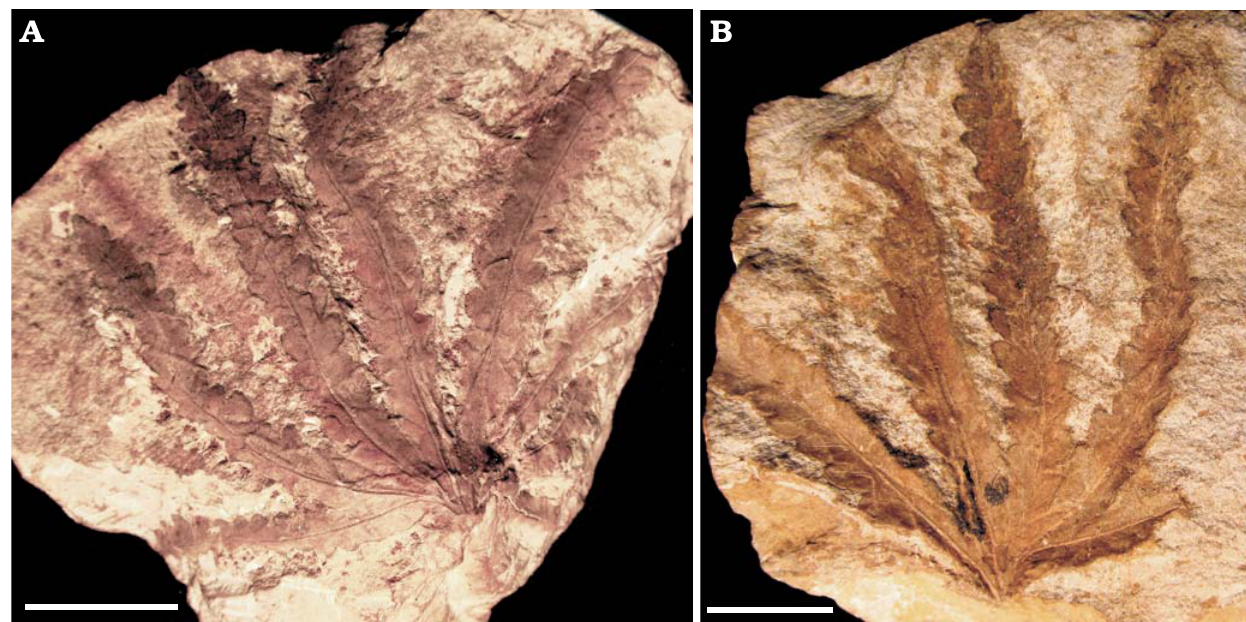
Fig. 3. Dipterid fern Dictyophyllum castellanosi Stipanicic and Menéndez, 1949, from Barreal Formation (Anisian, Middle Triassic) of Barreal-Calingasta, San Juan Province, Argentina. BAPb 6227, part ( A ) and BAPb 6228 counterpart ( B ). Scale bars 20